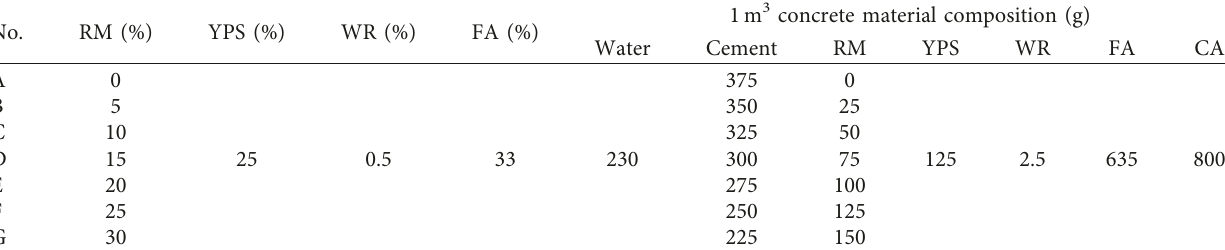
Table 5: Mixture proportions of RM-YPS-CC (by